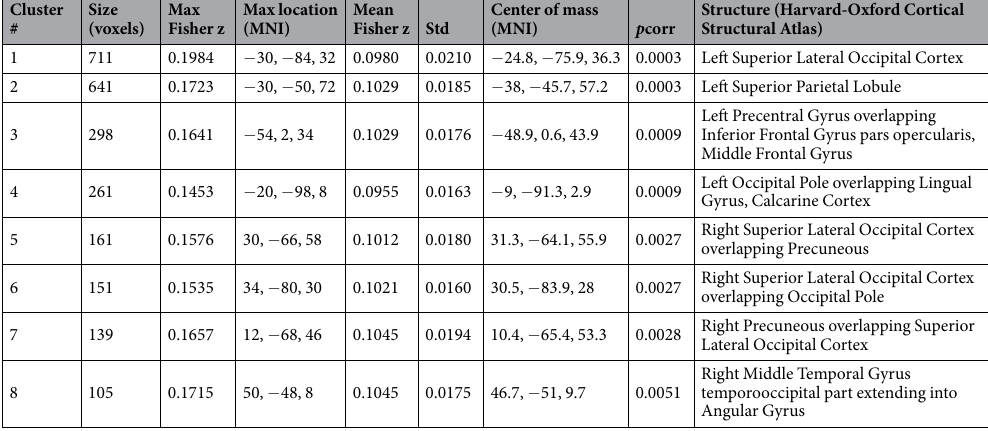
Right Inferior Lateral Occipital Cortex extending ventrally from Occipital Pole to bilateral Inferior Temporal Gyrus and Middle Temporal Gyrus. Extending